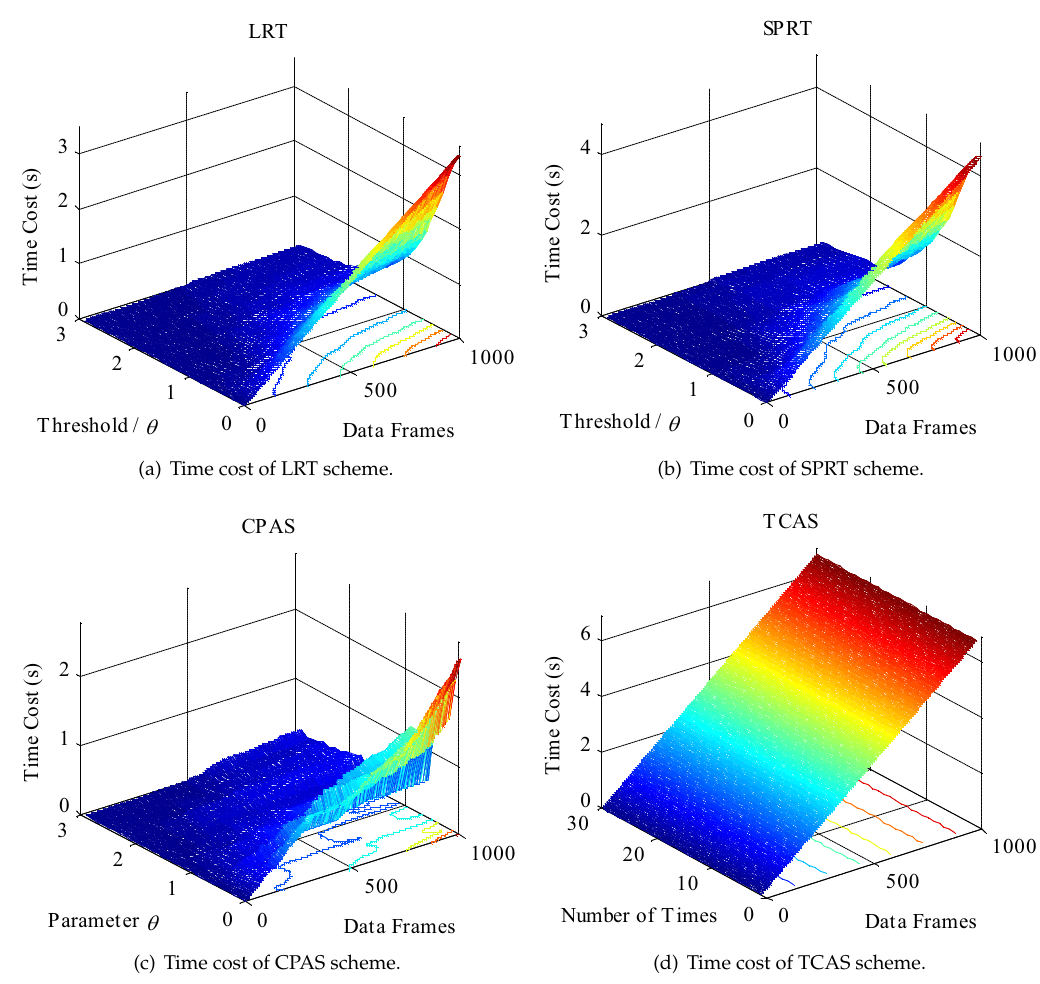
Figure 15. Three dimensional plots of time cost. Note that RC4 algorithm was employed to act a lightweight cryptographic algorithm in the experiments: ( a ) the time cost of LRT scheme; ( b ) the time cost of SPRT scheme; ( c ) the time cost of the proposed scheme, CPAS; and ( d ) the time cost of the traditional cipher authentication scheme,